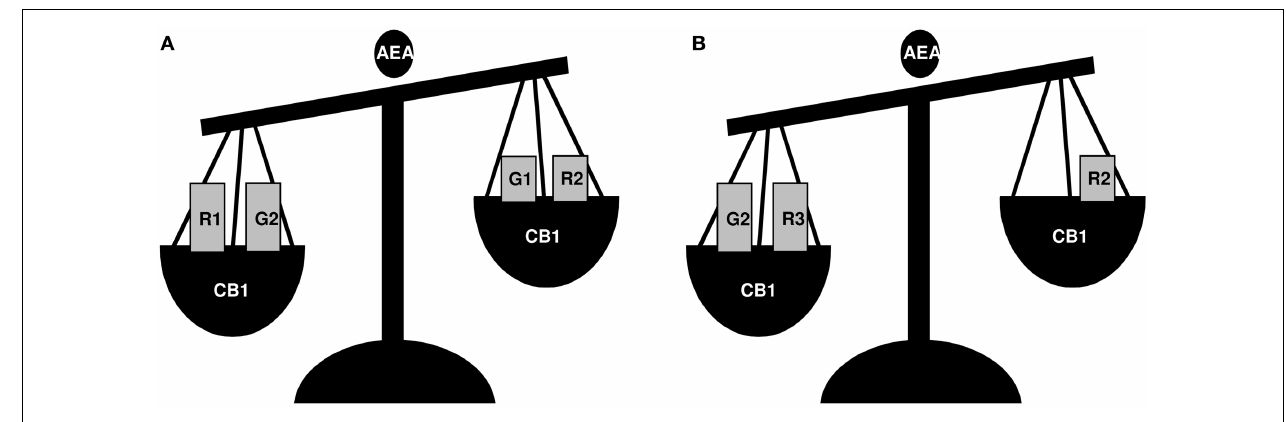
GnRH-R1 and GnRH-2 whereas it decreased those of GnRH-1 and GnRH-R2 , and had no effect on GnRH-R3 ; in February, AEA treatment increased GnRH-2 and GnRH-R3 expression, decreased GnRH-R2 , and had no effect on GnRH-1 or GnRH-R1 . In both periods, AEA-dependent effects occurred via CB1